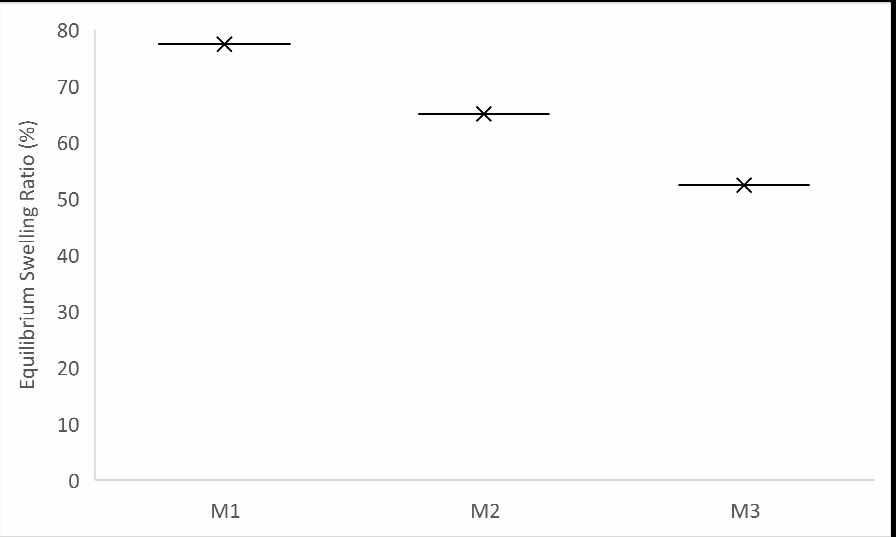
Figure 2. The produced pellets’ equilibrium swelling in PBS. Table 4. The Korsmeyer-Peppas model’s rate constants (k) and R 2 of the swelling data.